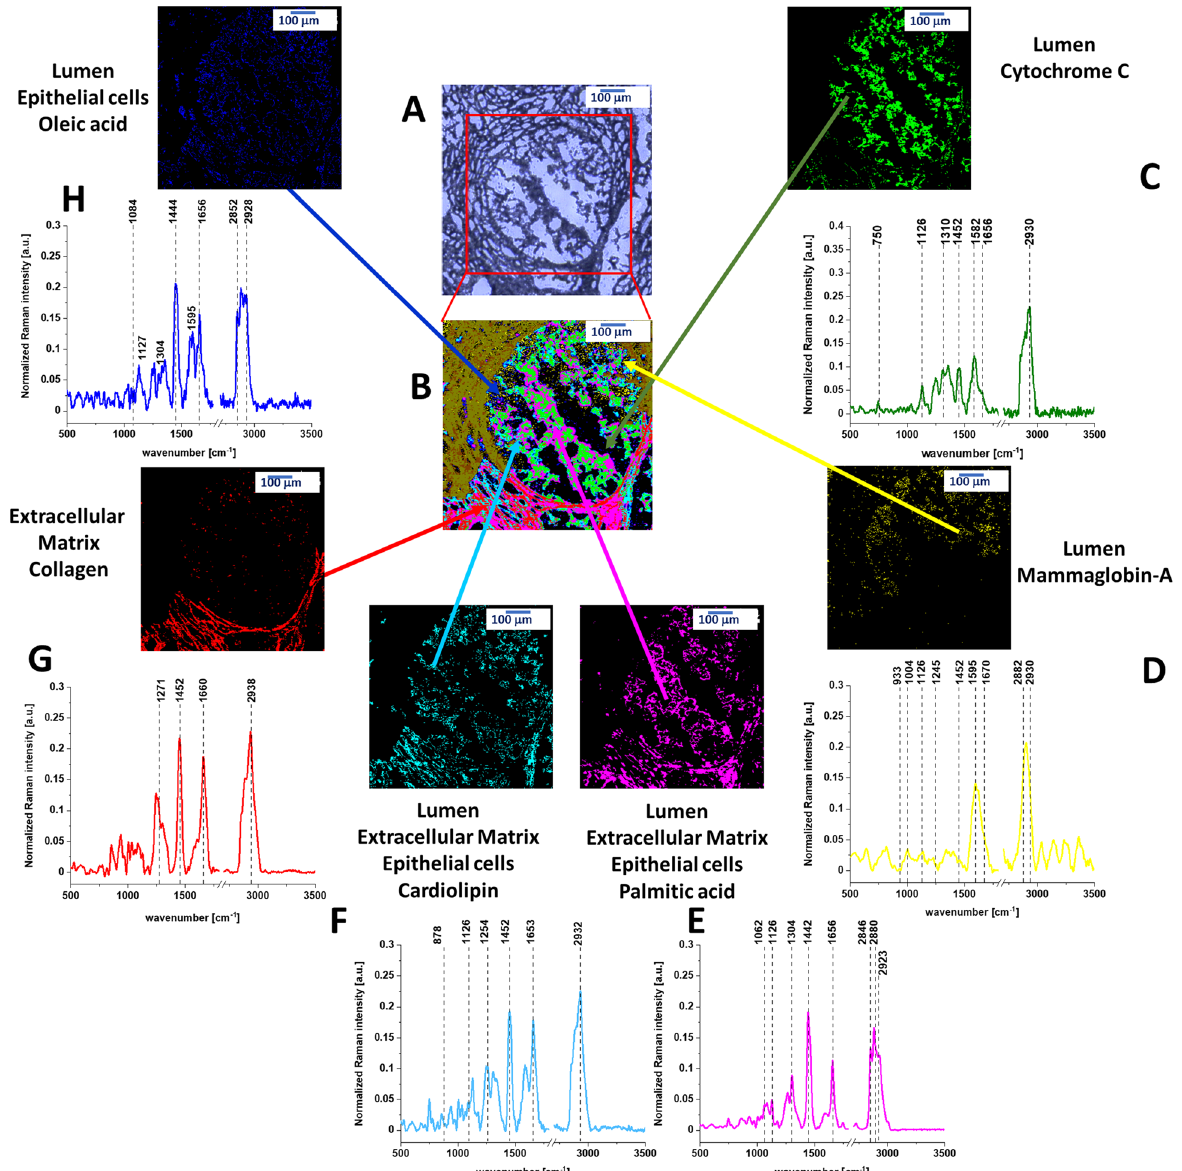
Figure 2. ( A ) Microscopy image of human cancerous duct, ( B ) Raman imaging of human cancerous duct obtained by using Cluster Analysis and Raman images and average Raman spectra (normalized by norm) of all clusters identified by Cluster Analysis: ( C ) cytochrome c (green), ( D ) mammaglobin-A (yellow), ( E ) palmitic acid (pink), ( F ) cardiolipin (turquoise), ( G ) collagen (red), ( H ) oleic acid